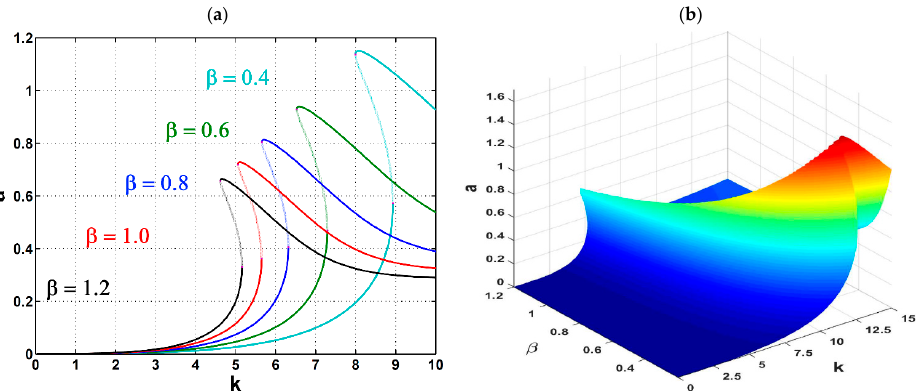
Figure 8. Relationship between the car’s oscillation amplitude a and ( a ) the excitation amplitude k at different values of cubic-nonlinearity parameter β , ( b ) both the excitation amplitude k and cubic-nonlinearity parameter β , at ζ = 0.02 and ω = 1.1 pre-control ( k p = k v = 0). Activation of the control unit is discussed and plotted in Figures 9–12 with different adopted values of both the CP control gain (cid:1863) (cid:3043) and the NV control gain (cid:1863) (cid:3049) . The relation- ship of the car’s oscillation amplitude (cid:1853) versus the excitation frequency (cid:2033) and the CP control gain (cid:1863) (cid:3043) is portrayed in Figure 9 post-control but at (cid:1863) (cid:3049) = 0 . As shown above in Figure 5, the reduction of (cid:2010) could suppress the curve’s peak and force it to turn linear without any unstable paths. Based on Equation (9), raising the parameter (cid:1863) (cid:3043) in the